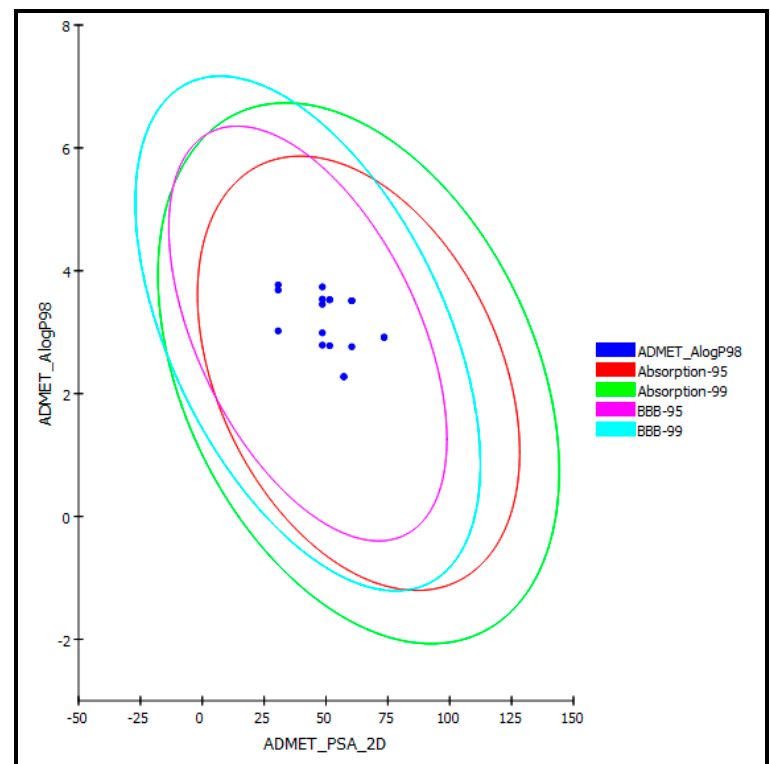
Figure 1. ADMET plot for a series of synthesized 1-aryltetrahydroisoquinoline derivatives displaying 95% and 99% confidence limit ellipses corresponding to the blood–brain barrier (BBB) and the human intestinal absorption (HIA) models. Table 2. In silico TOPKAT evaluation of the series of synthesized 1-aryltetrahydroisoquinoline de- rivatives